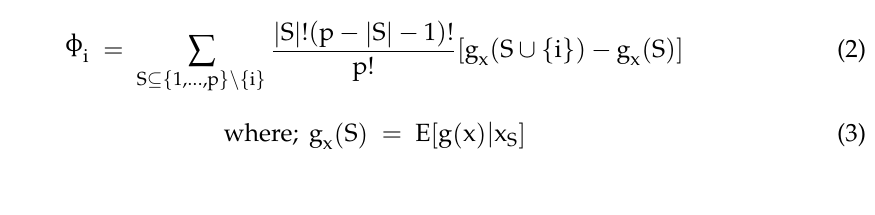
Table 1. Descriptive statistics of the data set. Description